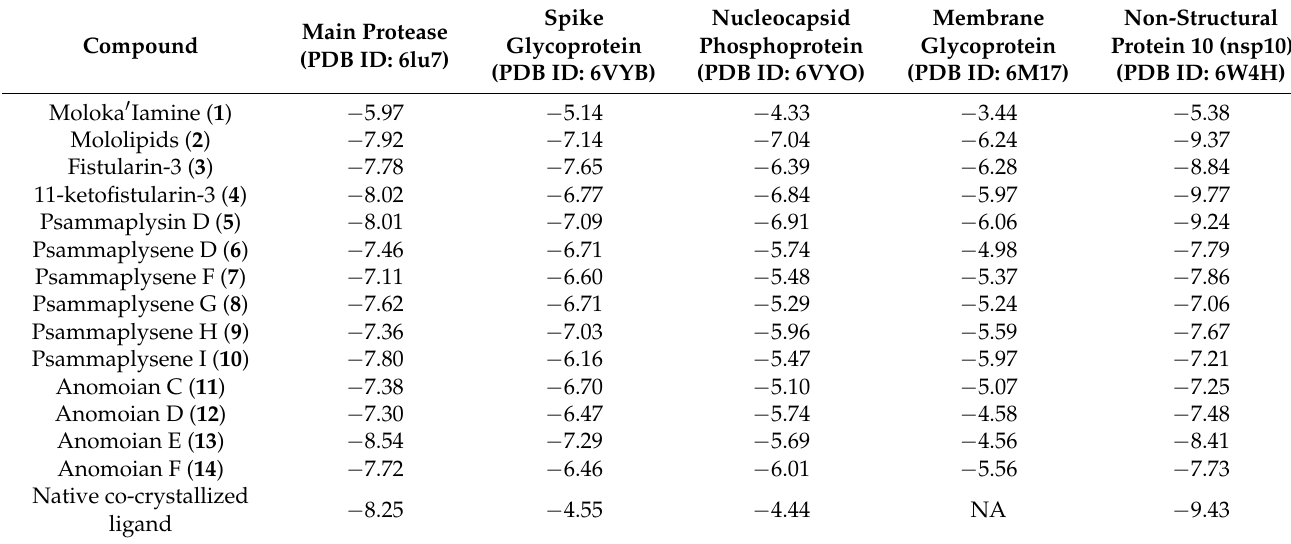
Table 1. Docking S-score (Kcal/mol) for screening library compounds compared to those of co-crystallized native ligands with the five SARS-CoV-2 target